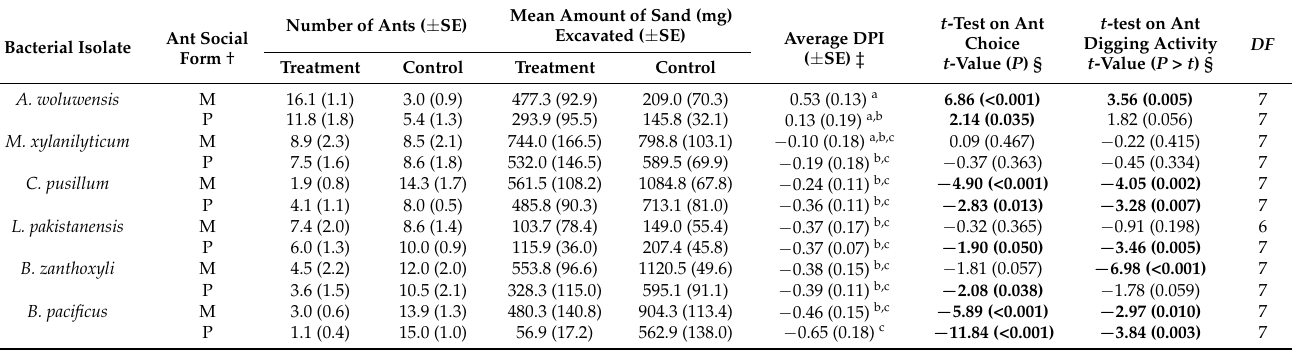
Table 5. Effects of soil-derived bacterial isolates presented at 5 × 10 7 cells/mL densities on monogyne and polygyne S. invicta location and digging activity in bacteria-treated or control sand and digging preference index (DPI) after 18 h.